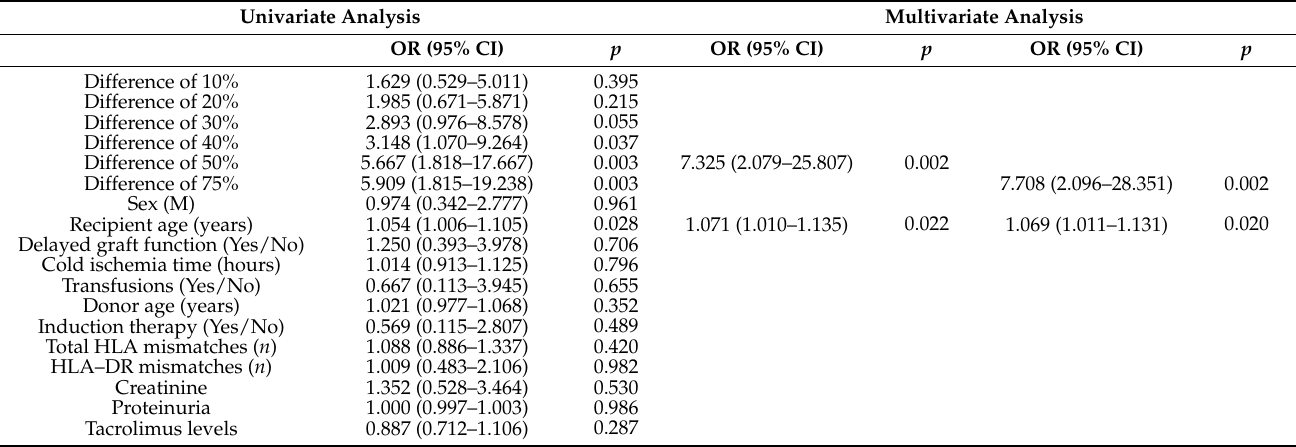
Table 3. Logistic regression to determine risk factors associated with the appearance of borderline lesions in the protocol biopsy.